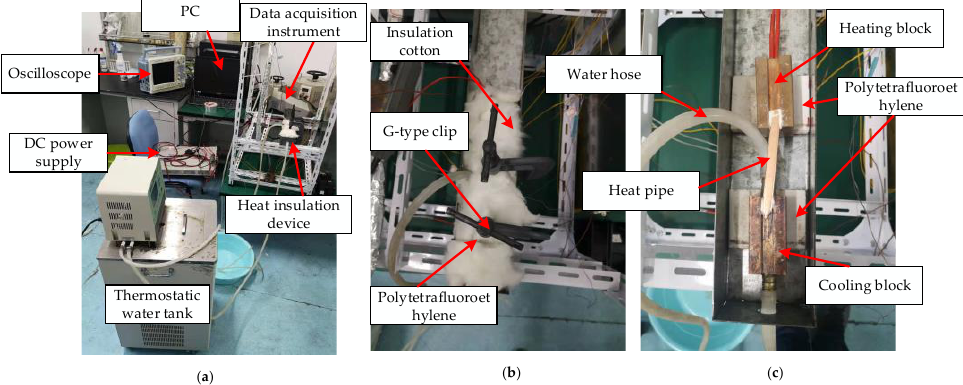
Figure 5. Experiment platform. ( a ) Overall platform. ( b ) Heat insulation device. ( c ) Internal view of the heat insulation device.